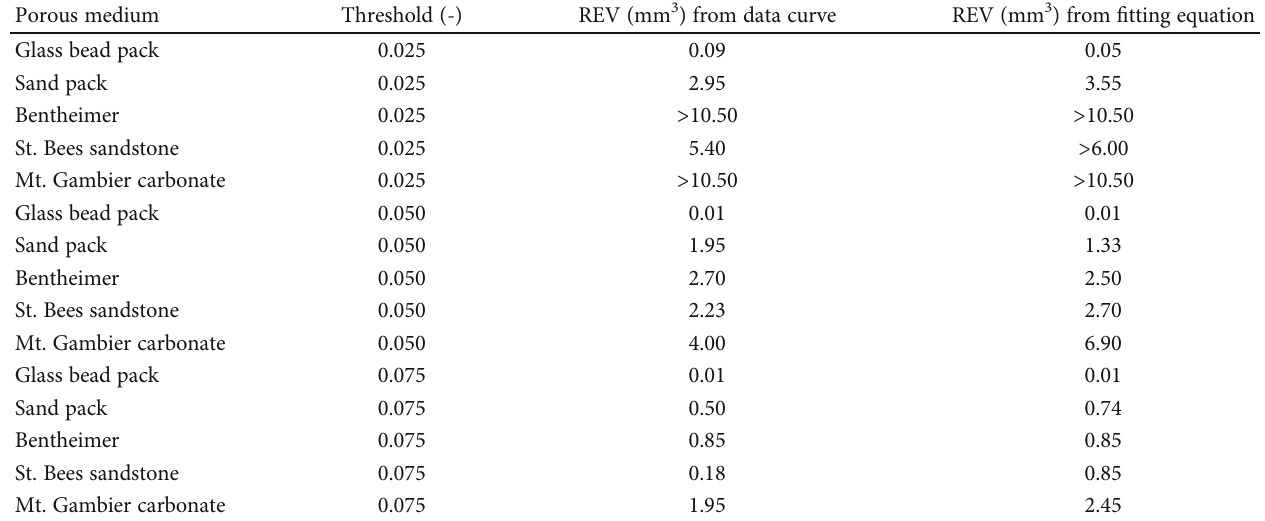
Table 7: In fl uence of CV threshold value on REV. Associated equations are listed in Table 6.